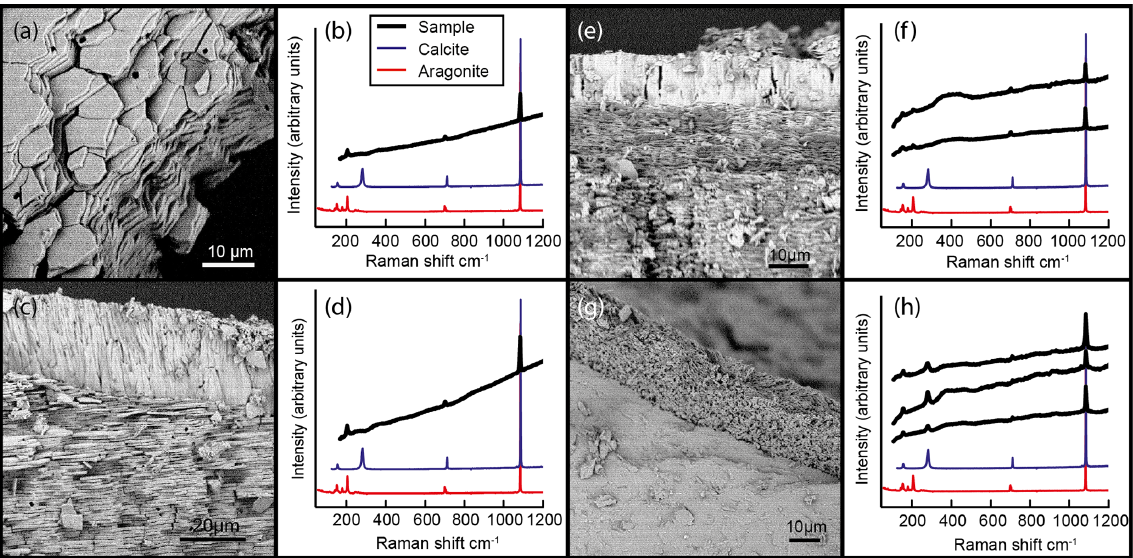
Figure 3. SEM images and Raman spectra for a selection of samples. ( a , c , e , and g ) SEM images of samples POL-8, POL-12, ARD-05, and ARD-03, respectively. ( b , d , f , and g ) Raman spectra of samples POL-8, POL-12, ARD-05, and ARD-03 compared to the reference spectra of calcite and